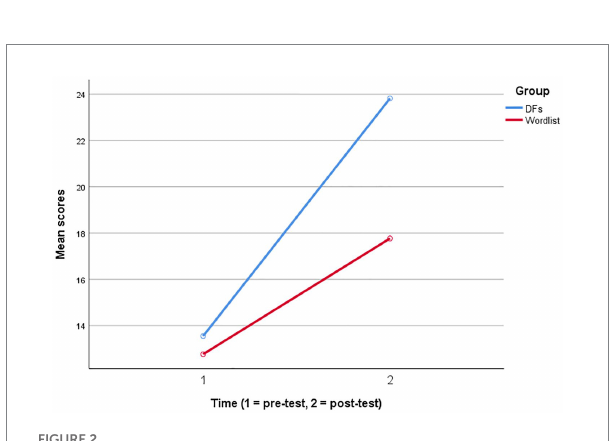
FIGURE 2 Estimated marginal means for the academic vocabulary knowledge